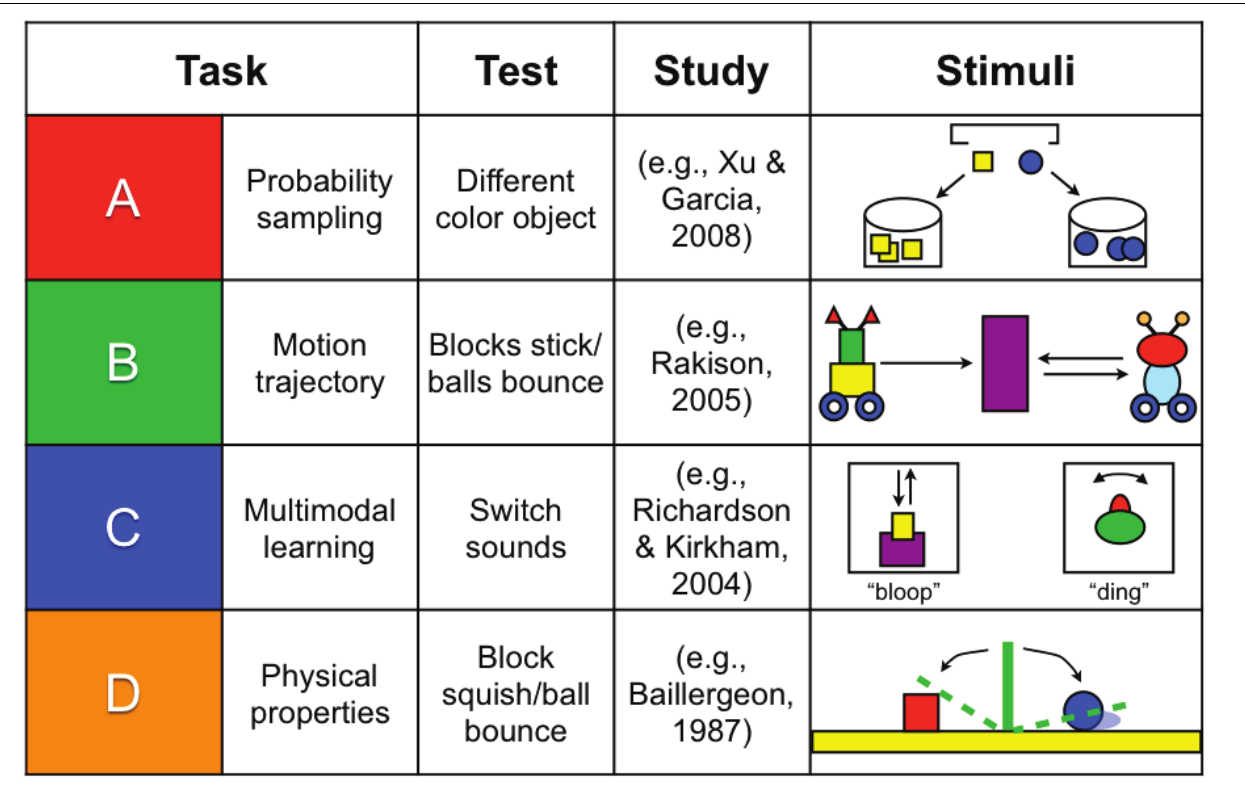
FIGURE 2 | Sample stimuli A–D. All events were counterbalanced for all infants (i.e., Event A for one infant was Event D for another infant).